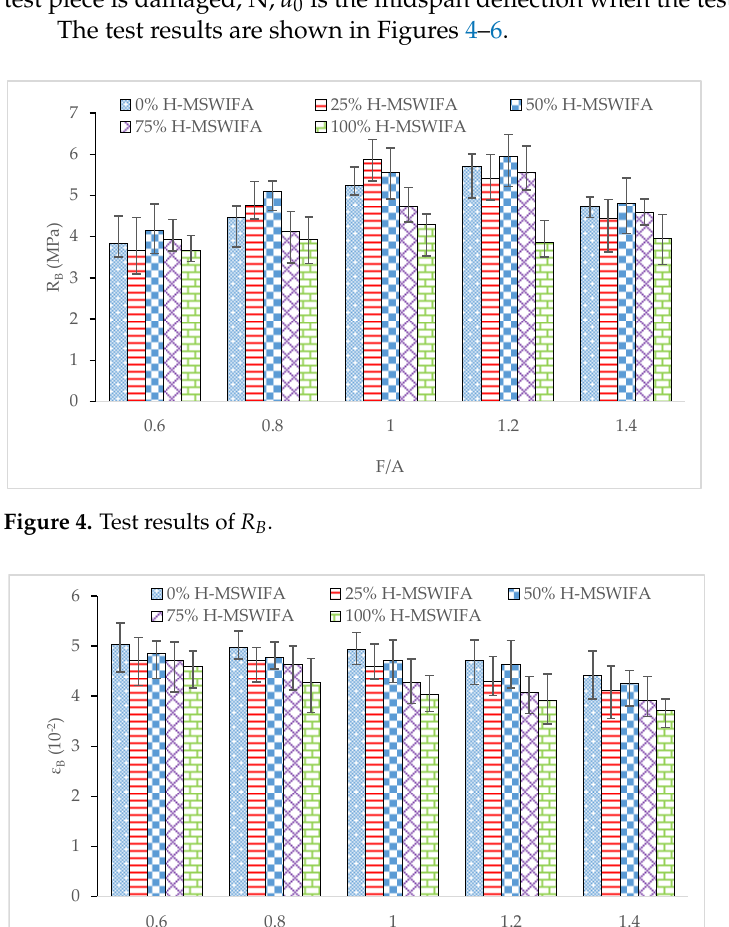
Figure 5. Test results of ε B .